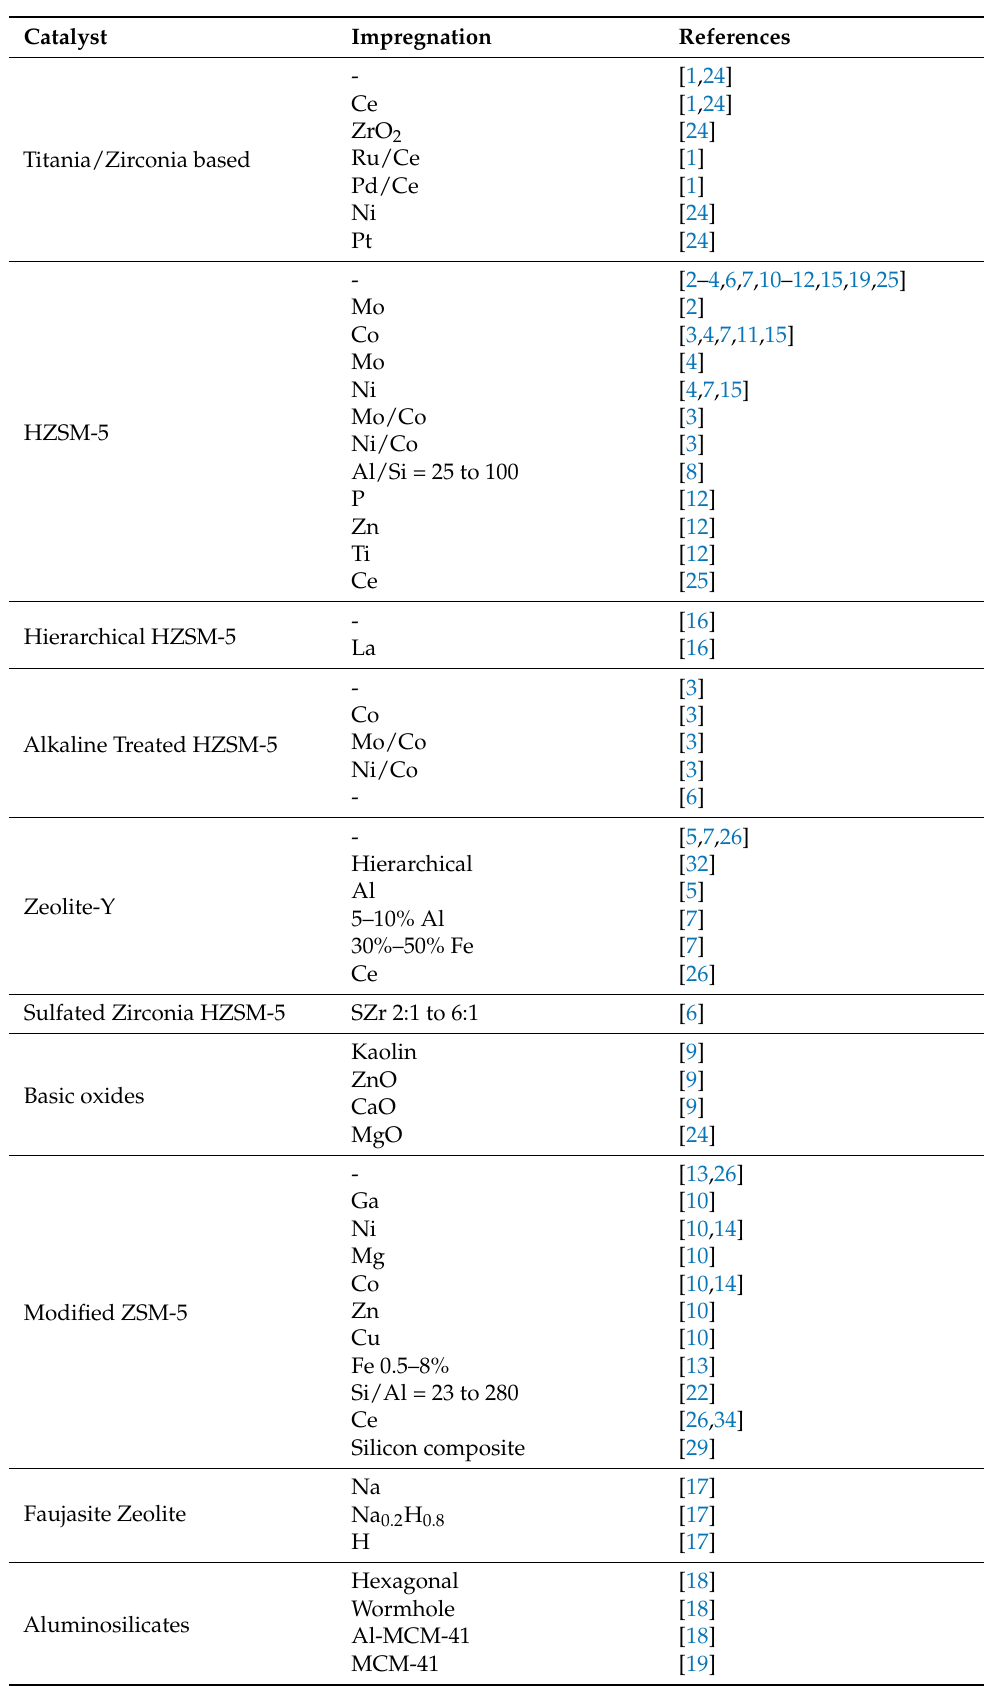
Table 1. Catalysts used on upgrading of pyrolysis vapors